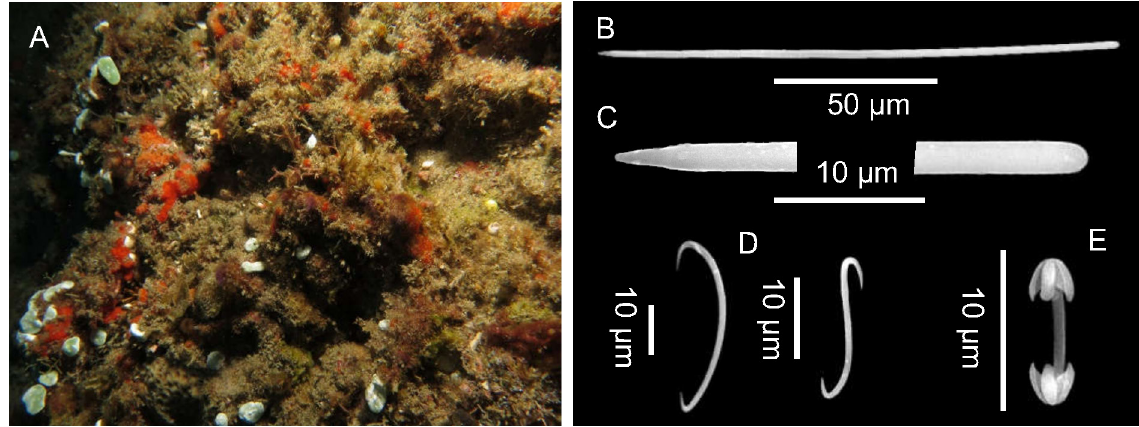
Fig. 19. Phoriospongia mozambiquensis Calcinai & Belfiore sp. nov. A . The holotype MSNG 61420